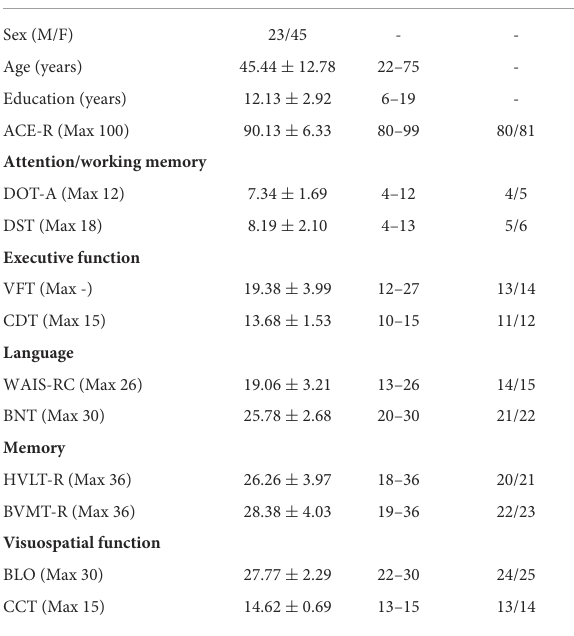
TABLE 1 Normative data of HCs on cognitive